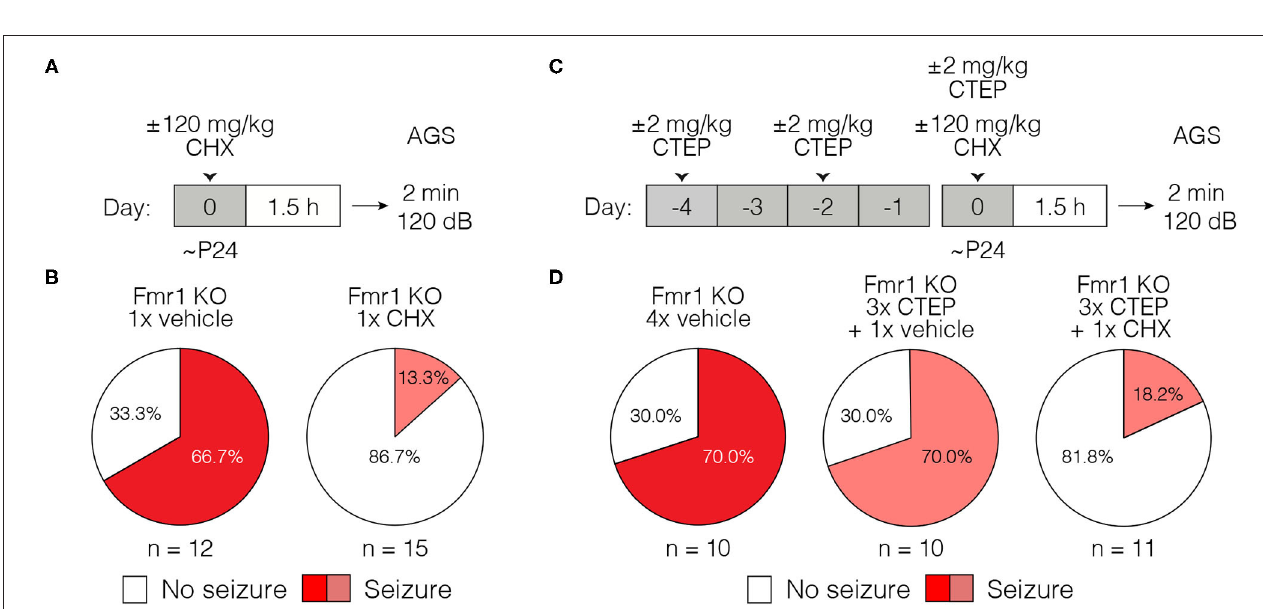
FIGURE 1 | exact test: p = 0.0038). (C) Schematic shows chronic CTEP dose schedule and AGS experimental design. (D) Chronic treatment (3 doses over 5 days) with 2 mg/kg CTEP no longer alleviates susceptibility to audiogenic seizures, indicating the development of acquired treatment resistance (Two-tailed Fisher’s exact